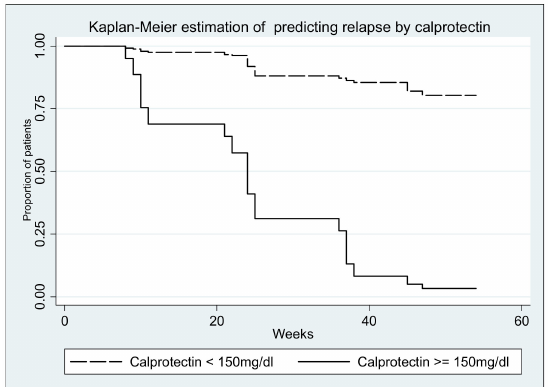
Figure 6. Log-rank test for equality of survivor functions (calprotectin) p < 0.00001.